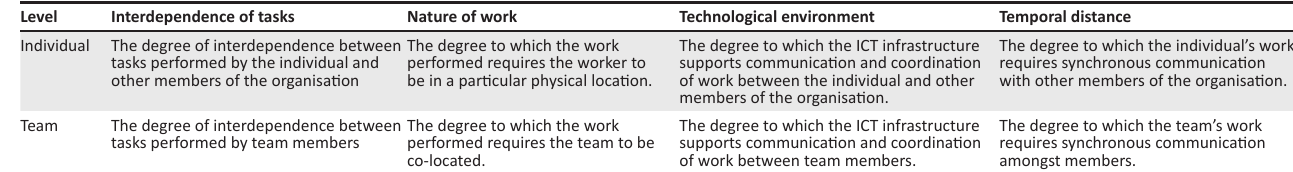
TABLE 10: Factors that influence organisational policy options for distributedness and virtuality at different organisational levels.